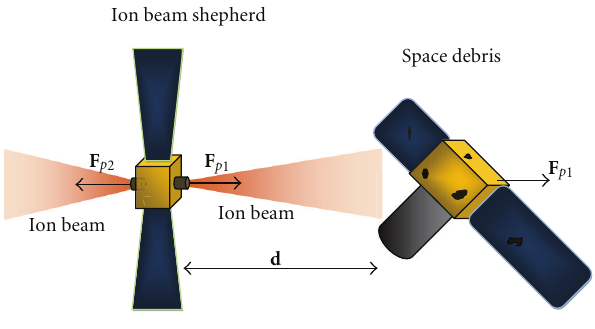
Figure 1: Ion Beam Shepherd